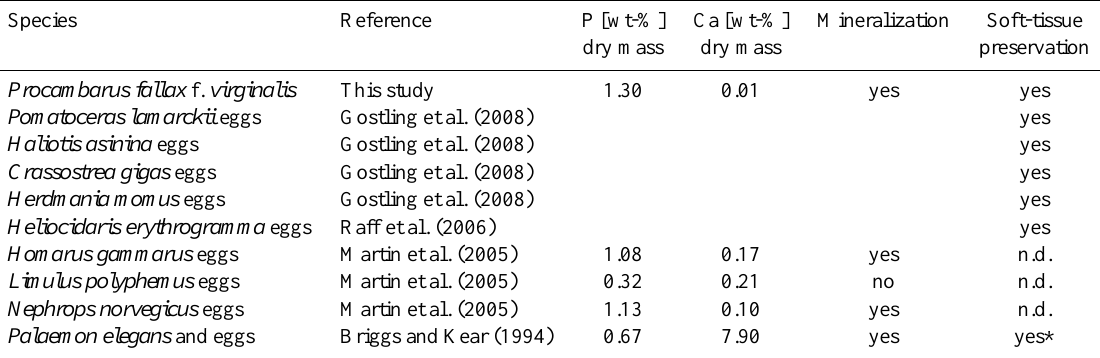
Table 3. Comparison of initial phosphorus and calcium concentrations, occurrence of mineralization and embryo preservation in this and previous